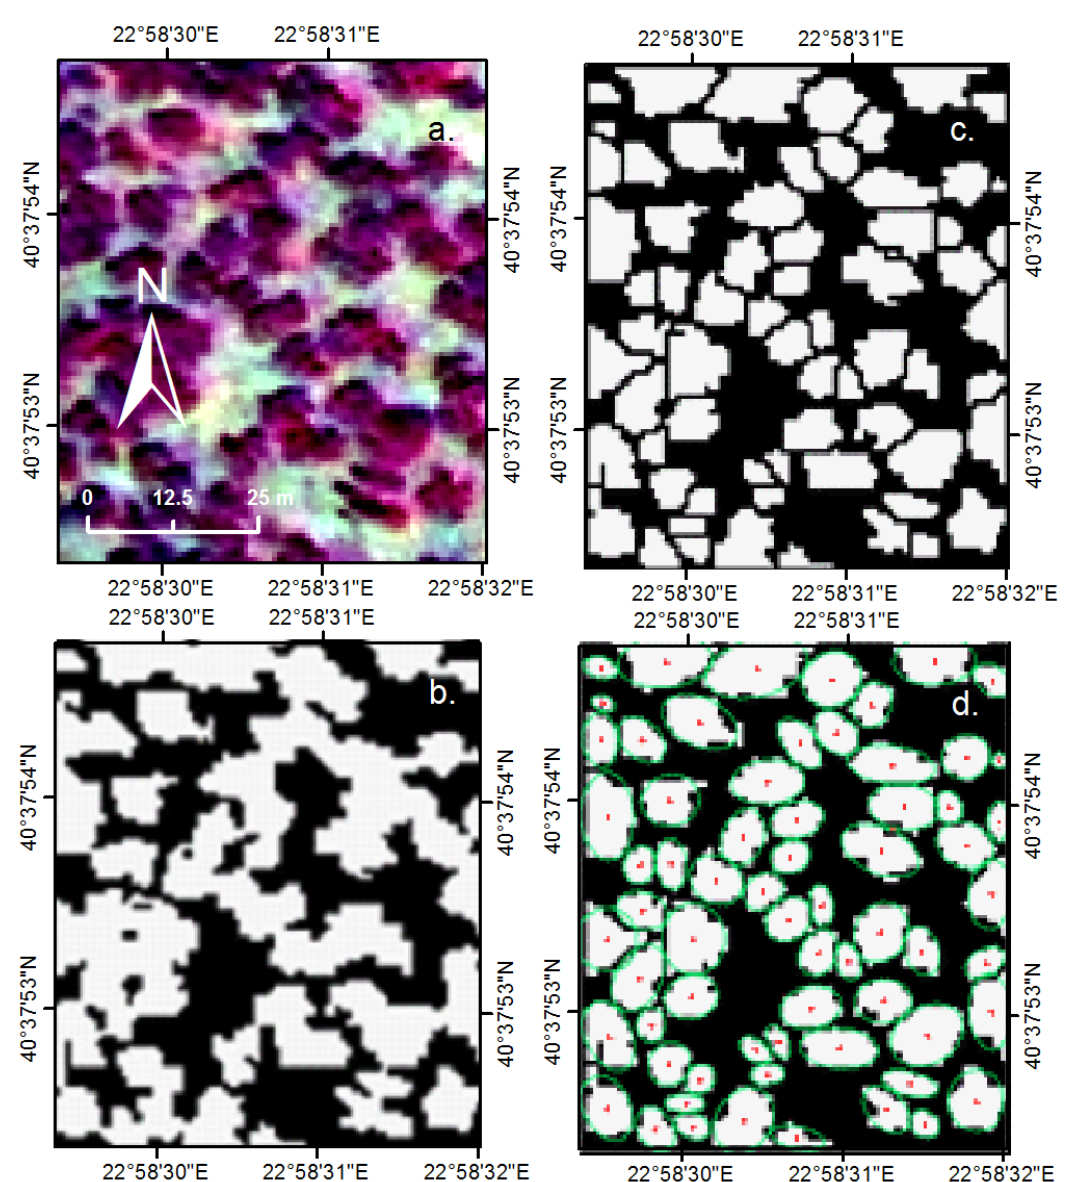
Figure 5. ( a ) Subset of the QUICKBIRD fused image, ( b ) results from the GEOBIA-based identification of pine tree crown regions, ( c ) preliminary results from watershed segmentation and ( d ) Matlab visualization of watershed segmentation with centroids (red) and ellipses (green) of detected